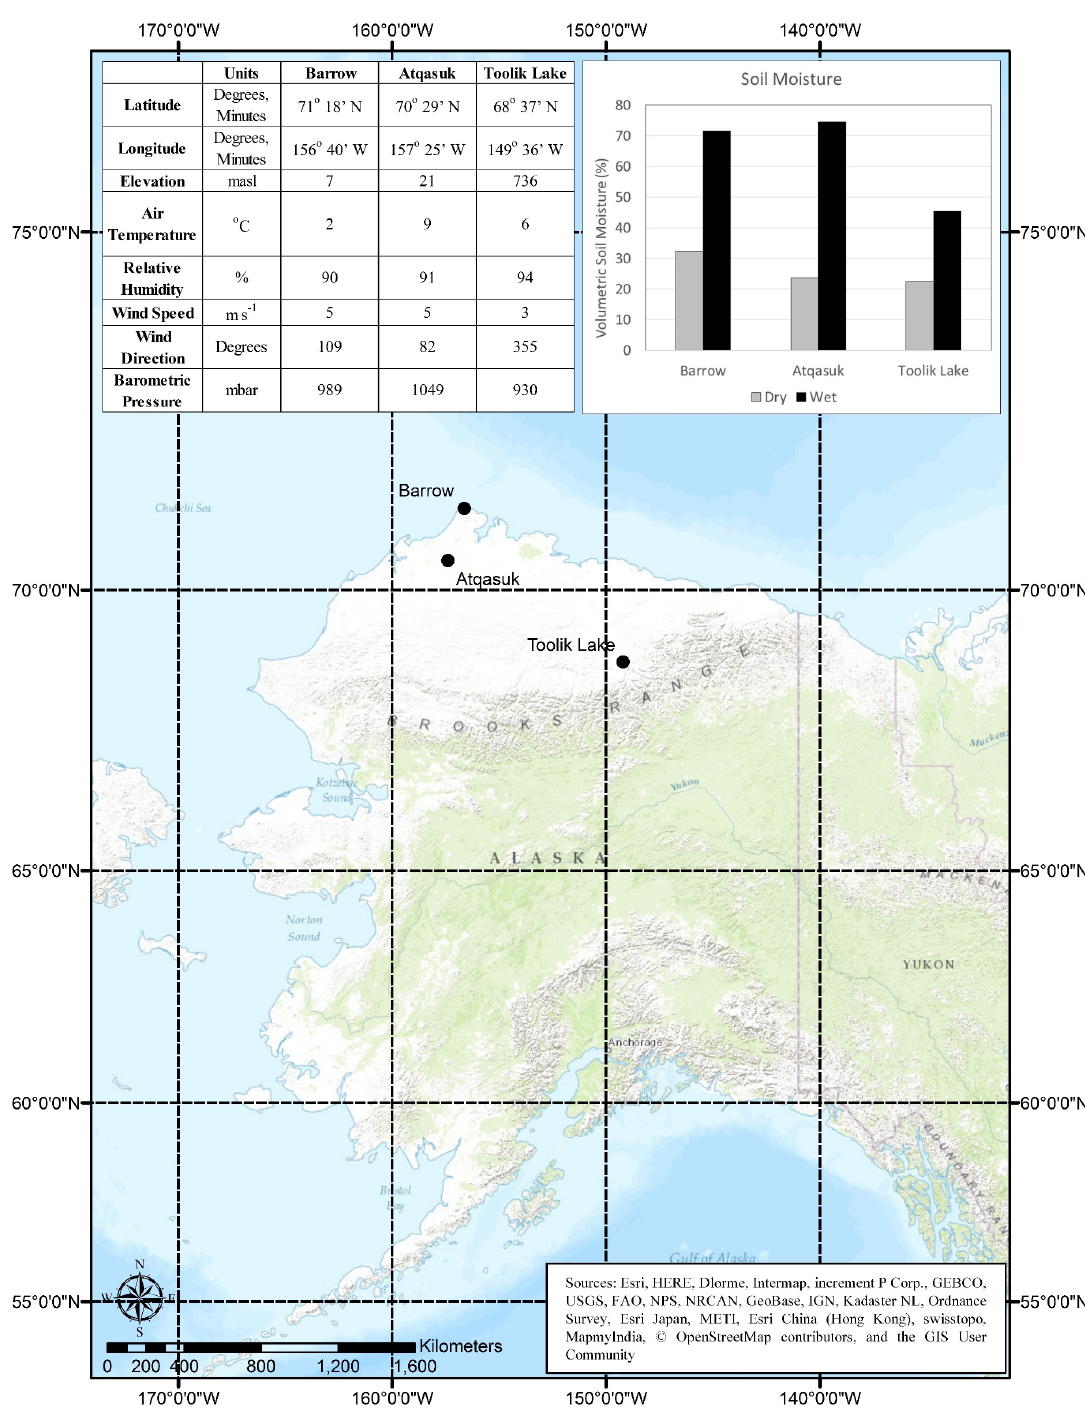
Figure 1. Map of the three locations used in this study along with weather data during image acquisition. Soil moisture measurements recorded within three days of image acquisition are from plots along the ITEX transects immediately adjacent to the study sites as described in Healey et al. [26] that represent the wet/moist and dry ITEX OTC/Control plots.